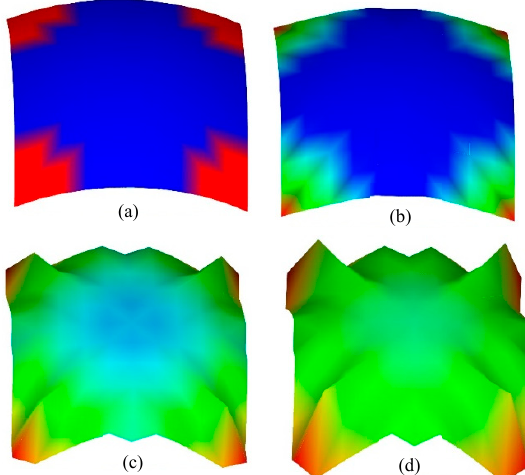
Figure 2. Z-displacement distribution of structures in Scheme A. The strain energy change ratio: ( a ) Step 1, 100%; ( b ) Step 40, 17.5%; ( c ) Step 120, 12.2%; ( d ) Step 248, 10.6%.